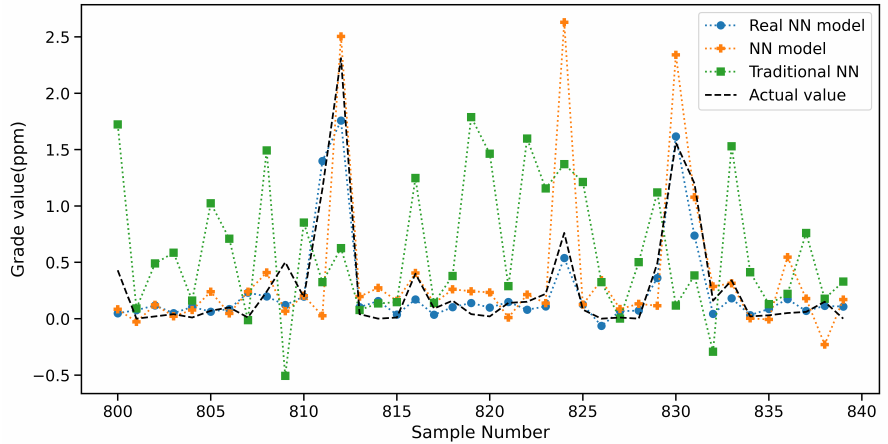
Figure 8. Simulation 23, comparison of NN models